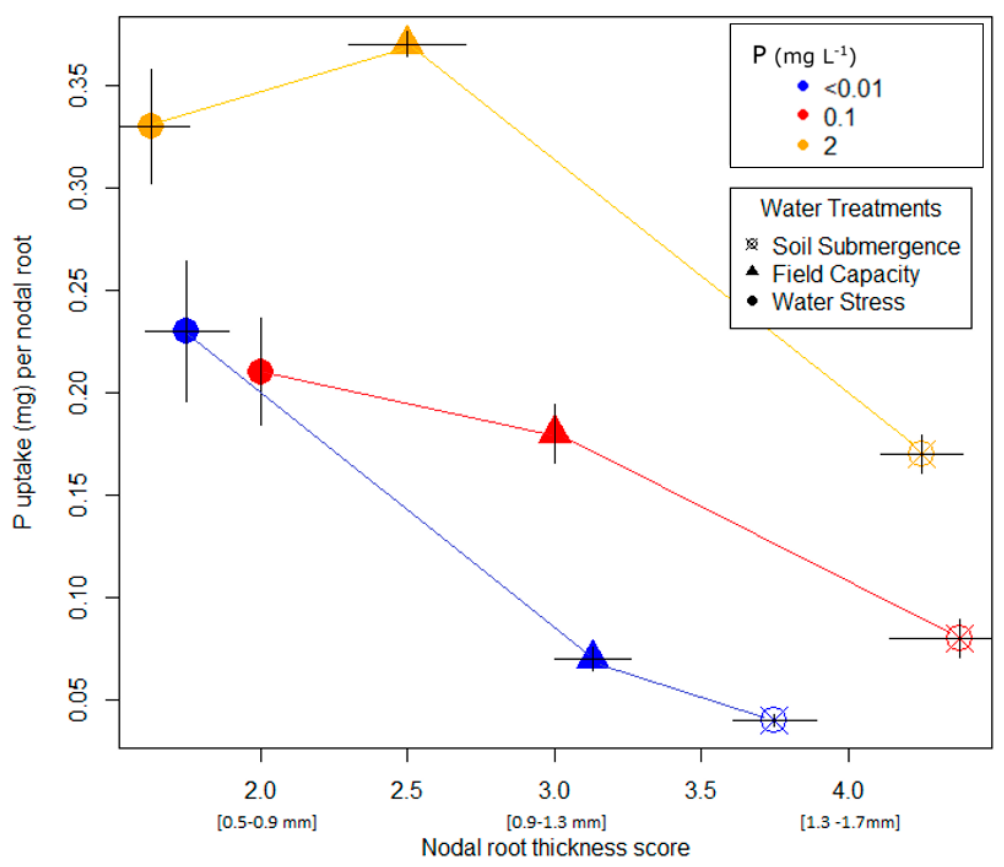
Figure 2. P uptake (mg) per nodal root versus the nodal root thickness scores from NERICA-L-19 grown in lowland soil (pots) under combinations of P rates (<0.01, 0.1, and 2 mg P L − 1 ) and water levels (water stress, field capacity, and soil submergence). Standard errors of the means are presented by the error bars. With decreased water availability root thickness decreases and P acquisition efficiency (Pup nodal ) increases. Reduced soil P availability decreases P uptake per nodal root.